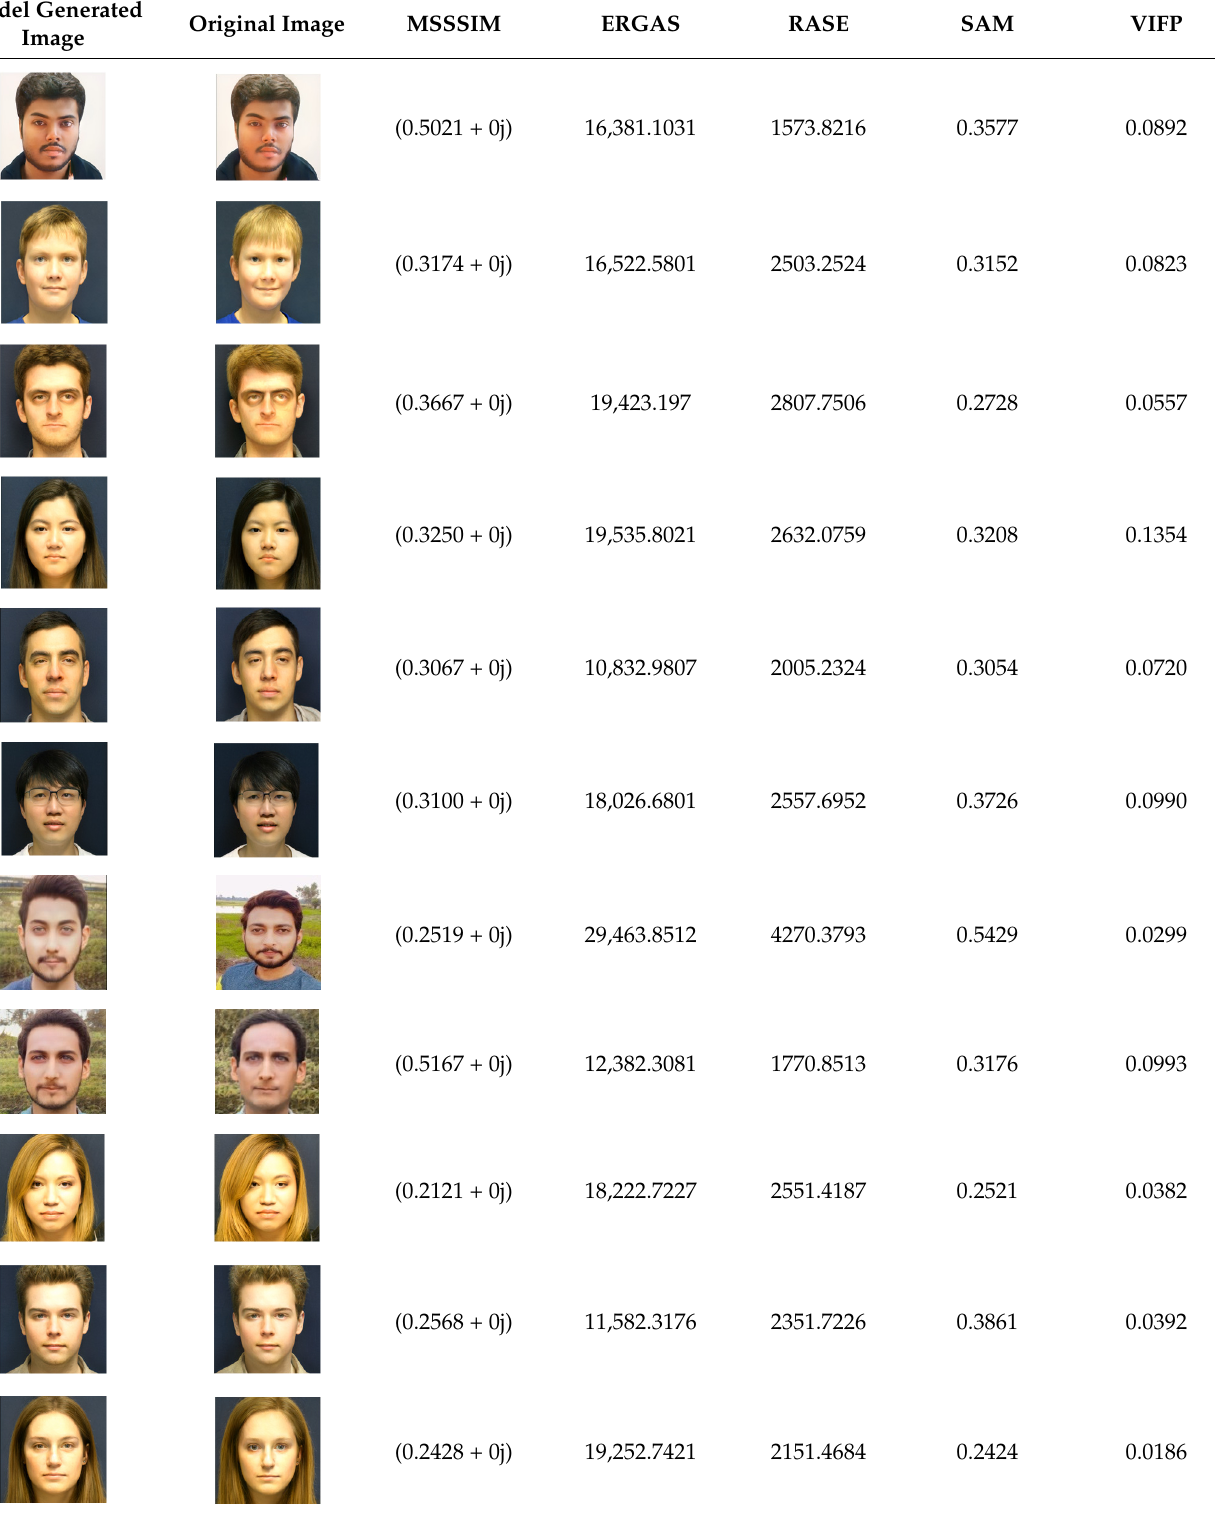
Table 3. MSSSIM, ERGAS, RASE, SAM, and VIFP evaluated on sample images. Model Generated Image